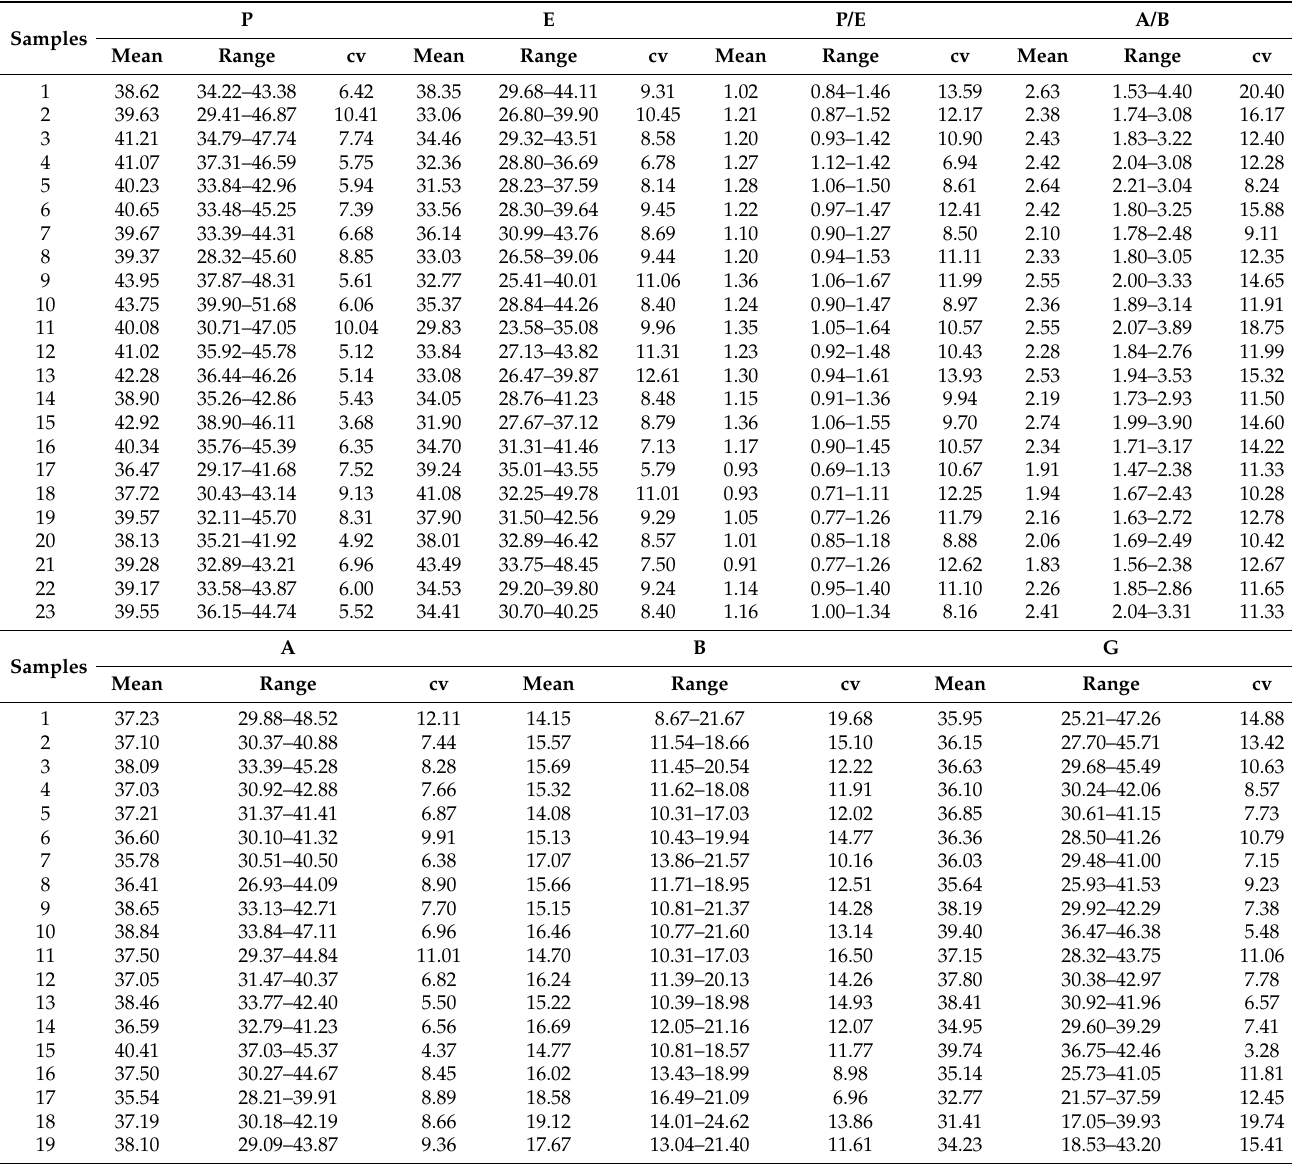
Table A1. Minimal, maximal, and mean value as well as coefficient of variation (cv, in %) for P, E, P/E, A/B, A, B and